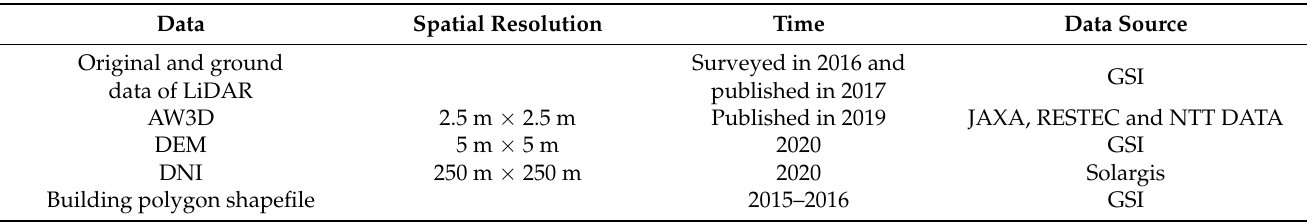
Table 1. Overview of the data